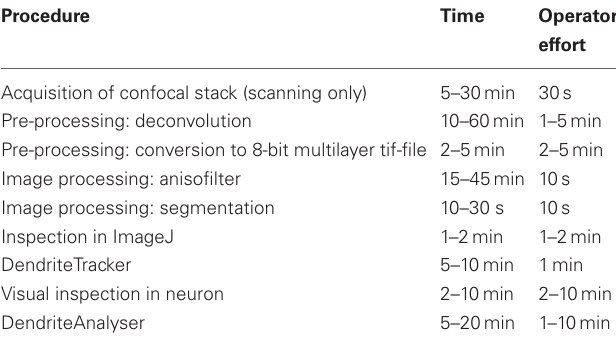
Table A1 | Processing times and operator